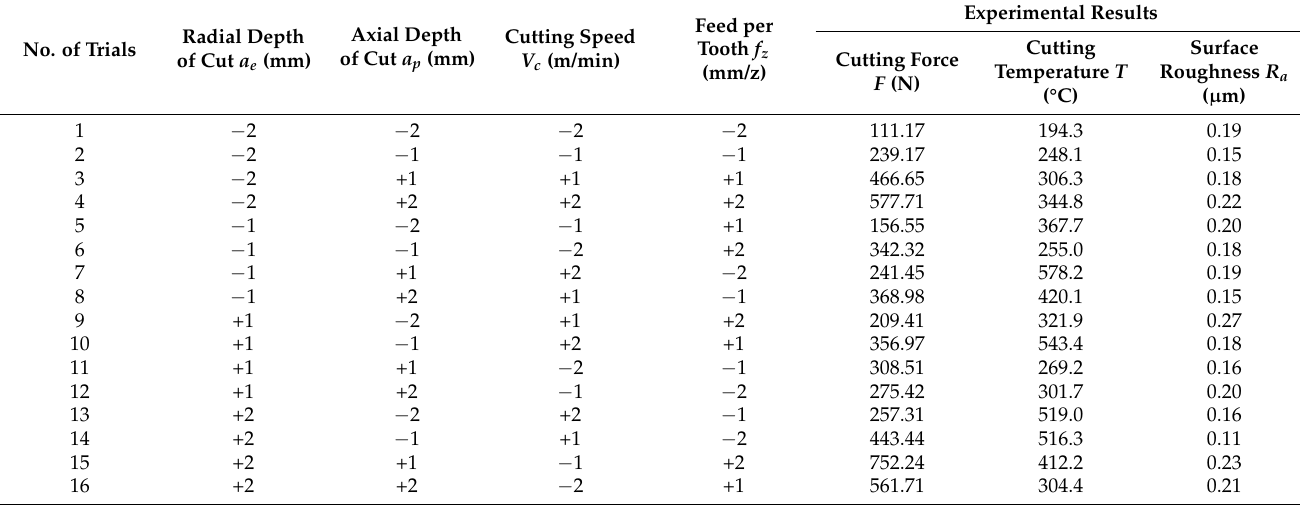
Table 2. L 16 (4 4 ) orthogonal series and experimental